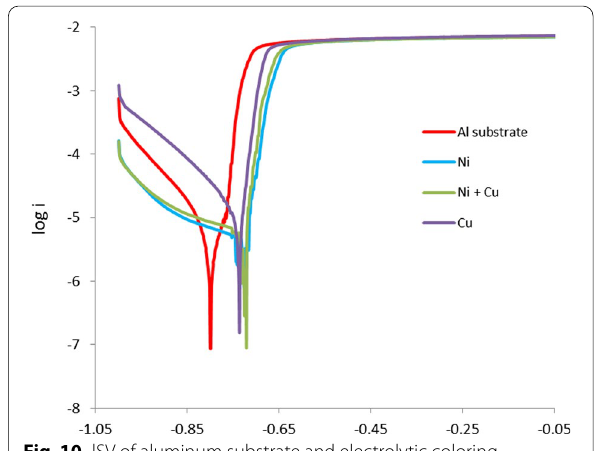
Fig. 10 lSV of aluminum substrate and electrolytic coloring aluminum samples by Ni, Ni